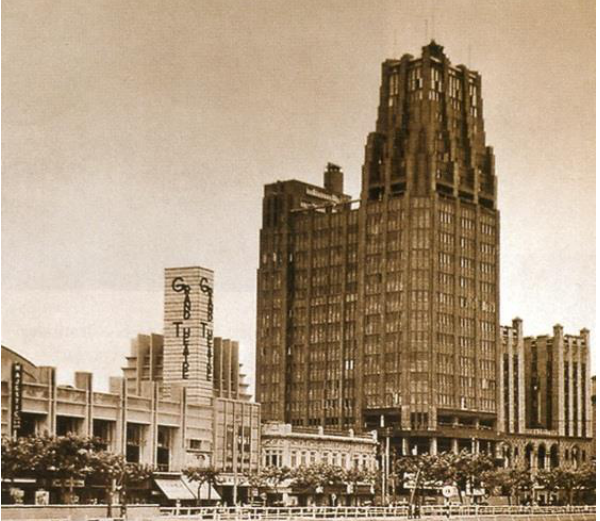
Figure 15. View from the racecourse towards the Grand Theatre and Park Hotel.